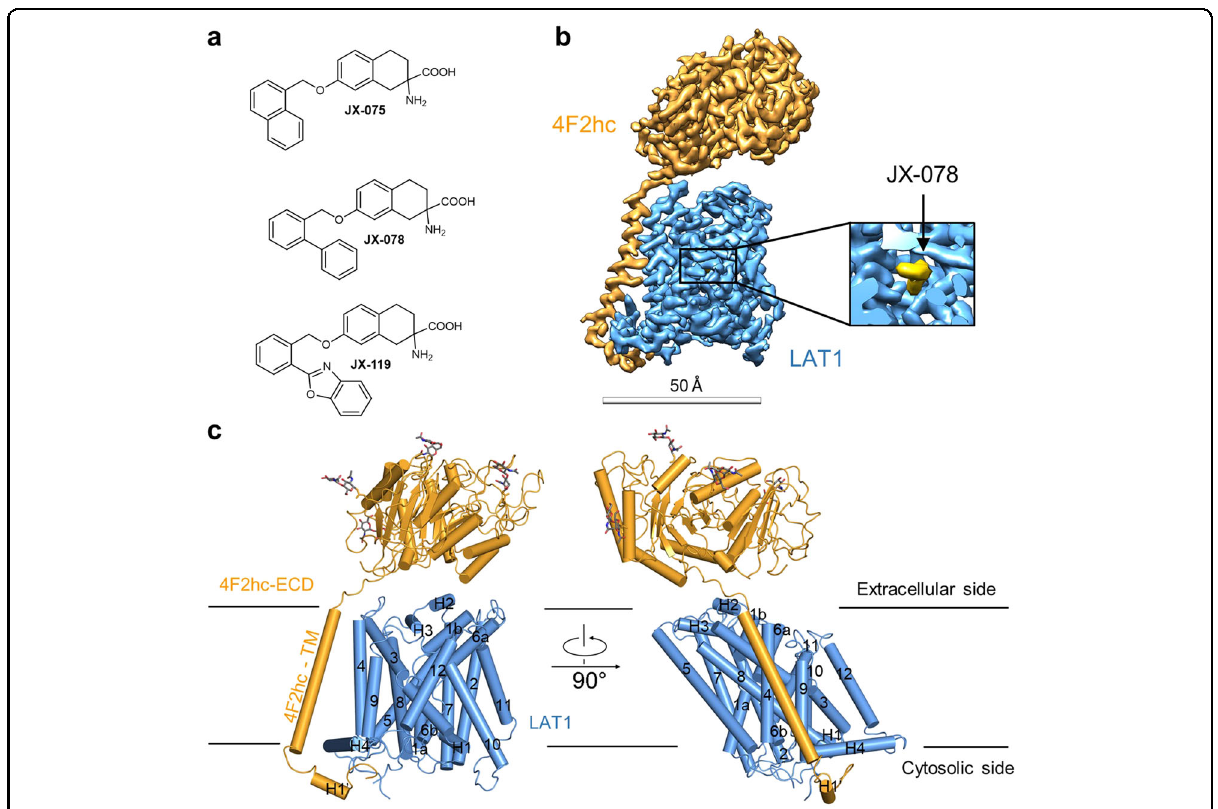
Fig. 1 Overall structure of the LAT1-4F2hc bound with JX-078. a Chemical formulas of the designed LAT1 inhibitors. b The overall cryo-EM map of the LAT1-4F2hc complex bound with JX-078. c The overall structure of the LAT1-4F2hc complex bound with JX-078. The glycosylation moieties are shown as sticks. H, helix. 4F2hc and LAT1 are colored orange and deep blue,